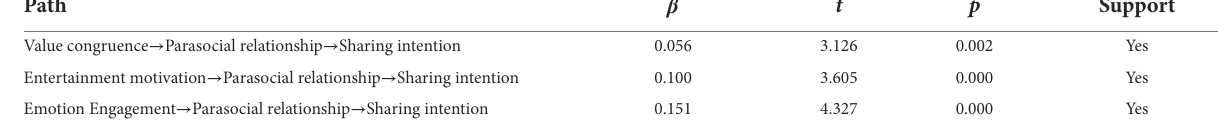
TABLE 6 Specific indirect effects in the structural